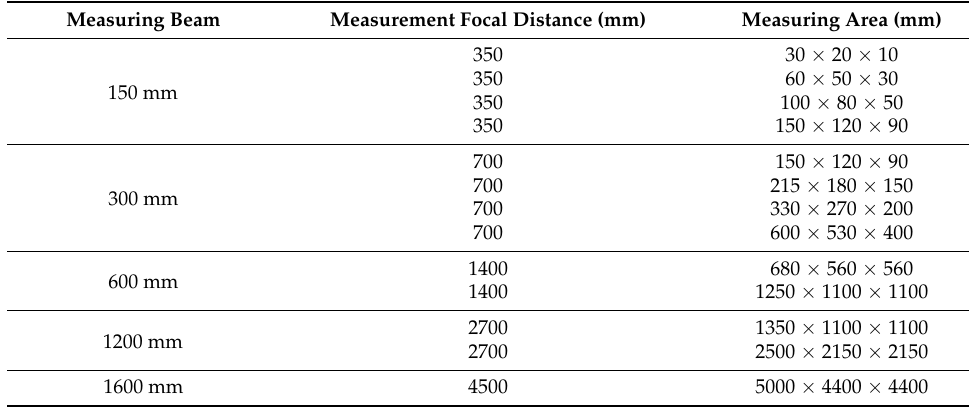
Figure 2. ( a ) Diagram of image acquisition by ARAMIS 3D system [40]; ( b ) ARAMIS 3D measurement system (photo: K. Walotek). Table 1. Summary of ARAMIS 3D measurement beams